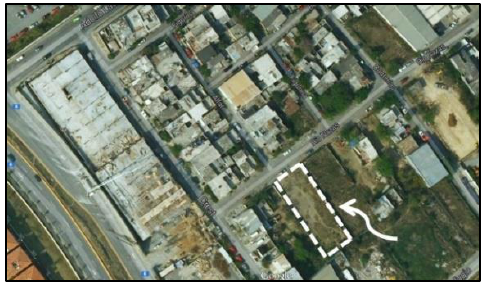
Figure 16. Aerial view of the analyzed space (Google & author digital manipulation, 2017).